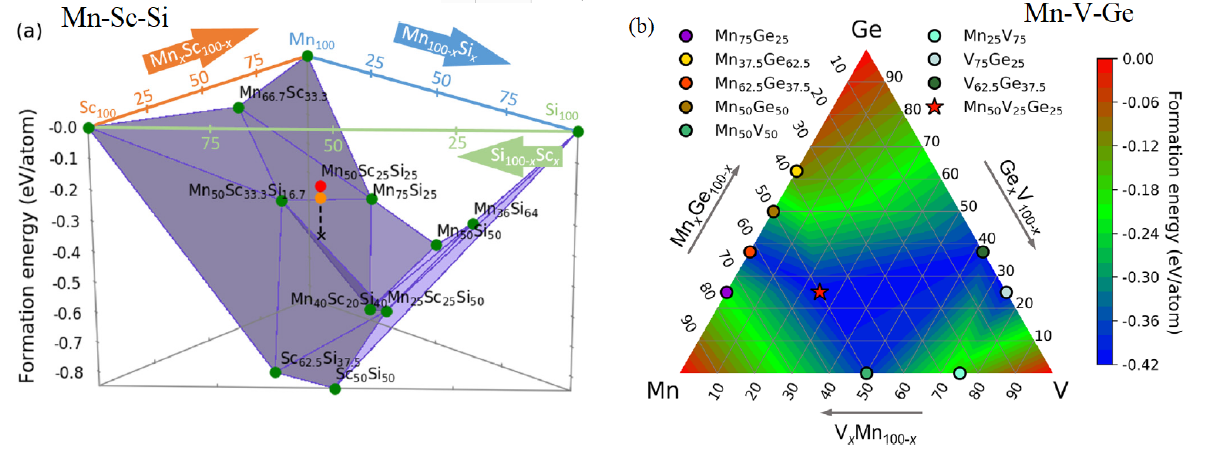
Figure 13. Energy convex-hull diagram for the ternary ( a ) Mn-Sc-Si [137] and ( b ) Mn-V-Ge [64] systems calculated within SCAN. The figures are adapted from Refs.